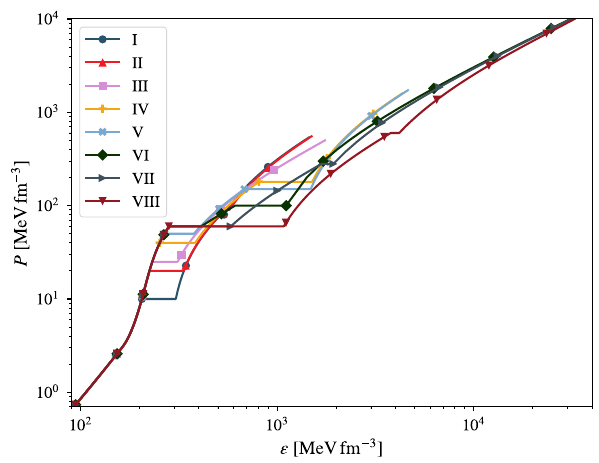
Fig. 1 Hybrid EOSs with two sequential QCD first order phase tran- sitions considered in our analysis Table 1 Transition pressure and jump in the energy density (both in MeVfm − 3 )forbothphasetransitionsandrespectivequarkmatterspeed of sound squared for the 2SC and CFL phases Hadronic